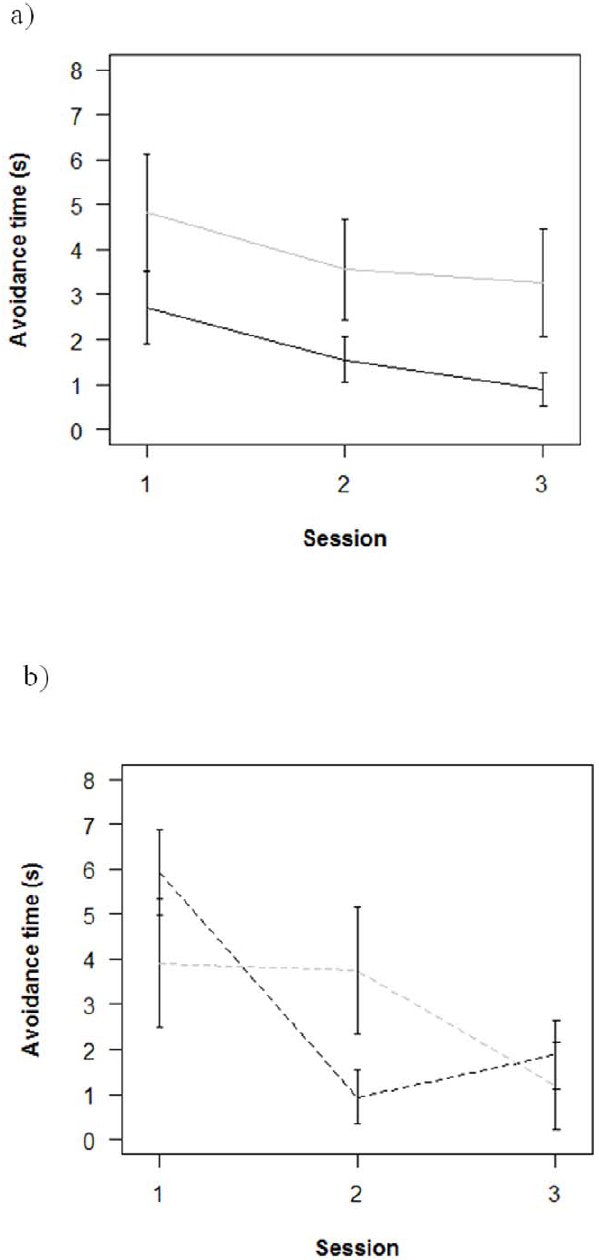
Figure 3. Groups with experienced Key individuals (black lines) were better able to avoid the stimulus. Groups with experienced Key individuals were better at avoiding the stimulus than were groups in which the experienced fish was a non-Key fish (gray lines). 3a) In PN fish, the effect of social role was in terms of faster escape for groups with experienced Key fish (solid black line) than for groups with experienced non-Key fish (solid gray line) at all three sessions. 3b) In SH fish, the difference was in terms of faster improvement: by the second session (S2) for groups with experienced non-Key fish (gray dashed line), but only by the third session (S3) for groups with experienced non-Key fish (gray solid line). Error bars are one standard error. Data are for the same trials as in Fig. 4, but combining data from males and females.